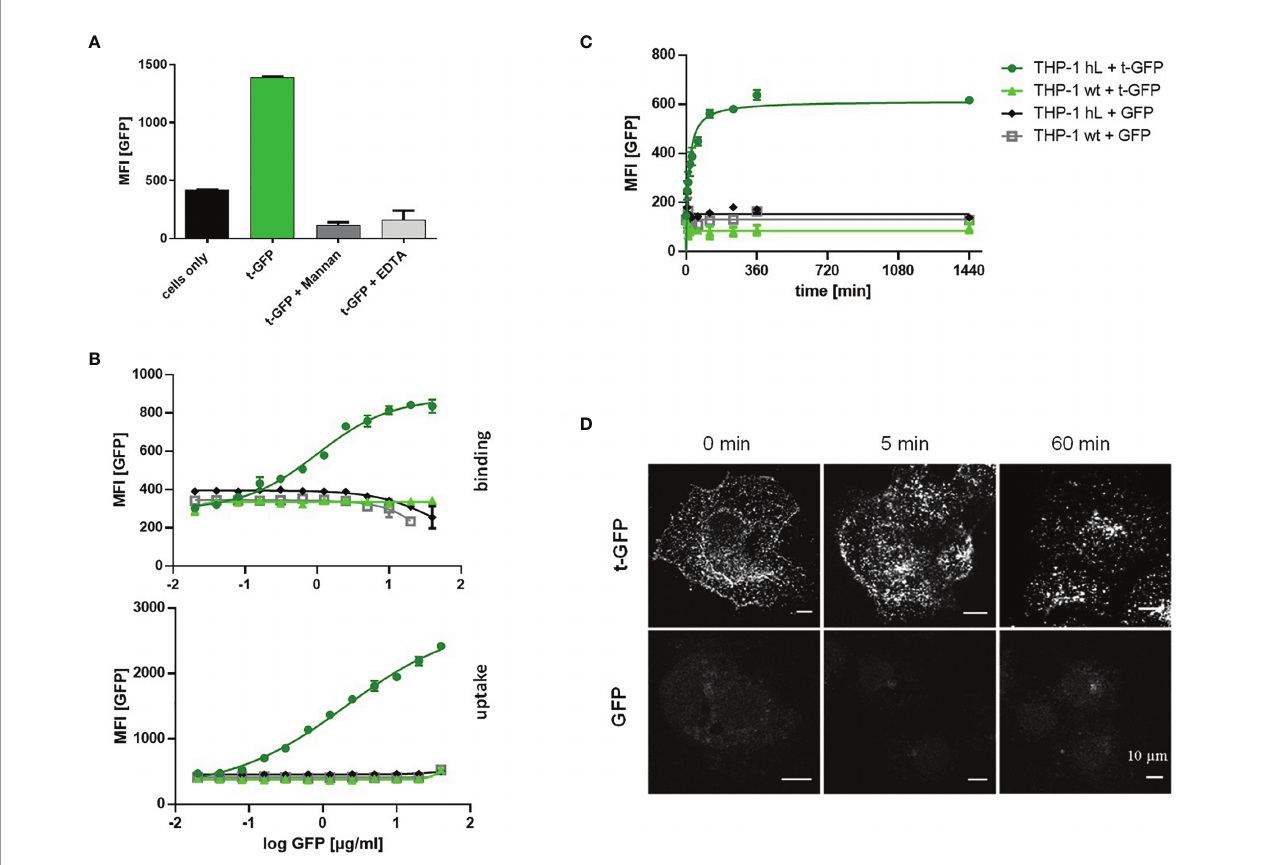
FIGURE 2 | t-GFP shows speci fi c binding and uptake by Langerin-expressing cell lines. (A) t-GFP binds to Langerin+ THP-1 cells and is inhibited by mannan and EDTA. n = 3 (B) binding and uptake of t-GFP occurs in a dose-dependent manner (C) kinetic analysis of t-GFP uptake into THP-1 cells. n = 3 (D) Fluorescence microscopy of Langerin + COS7 cells shows rapid and selective uptake of t-GFP in comparison to non-targeted